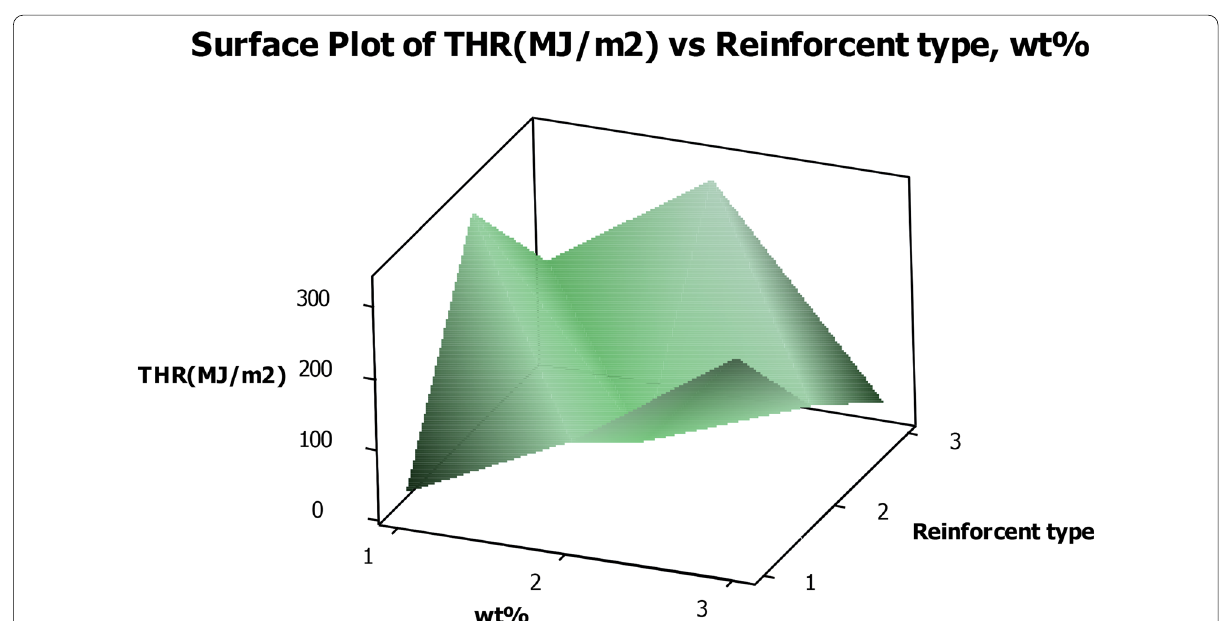
Fig. 13 3D plot of THR, reinforcement type and